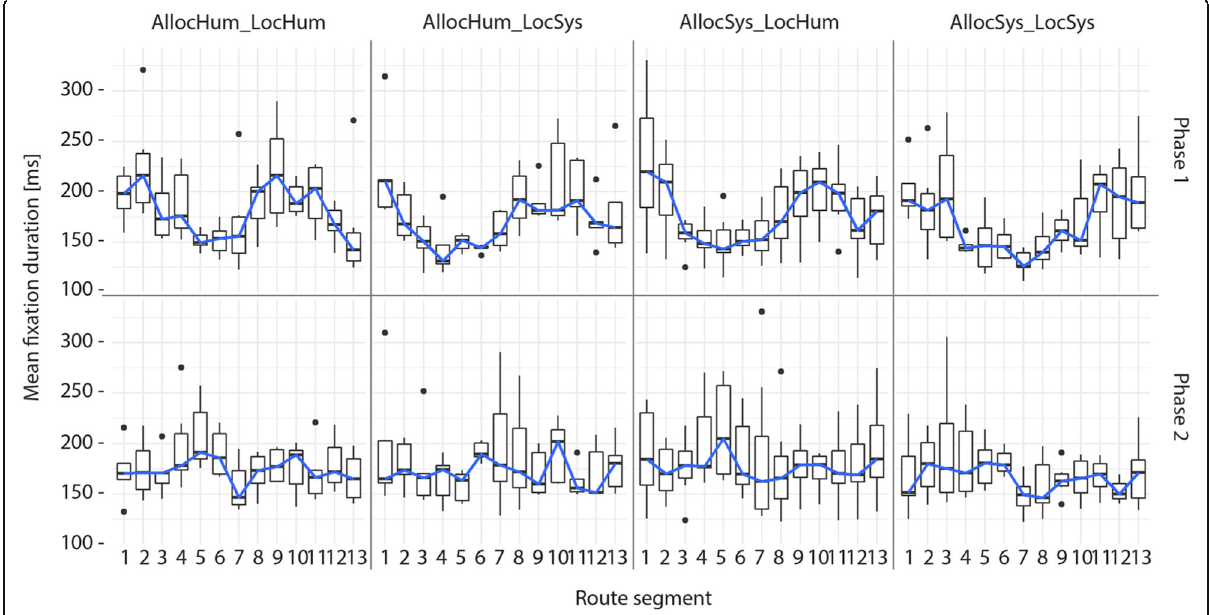
Fig. 9 Mean fixation duration in each segment of the route across the four conditions for the experimental Phase 1 and Phase 2. For each participant the walking direction was from Segment 1 to Segment 13 in Phase 1 (i.e., read graph from left to right) and from Segment 13 to Segment 1 in Phase 2 (i.e., read graph from right to left). Black dots indicate